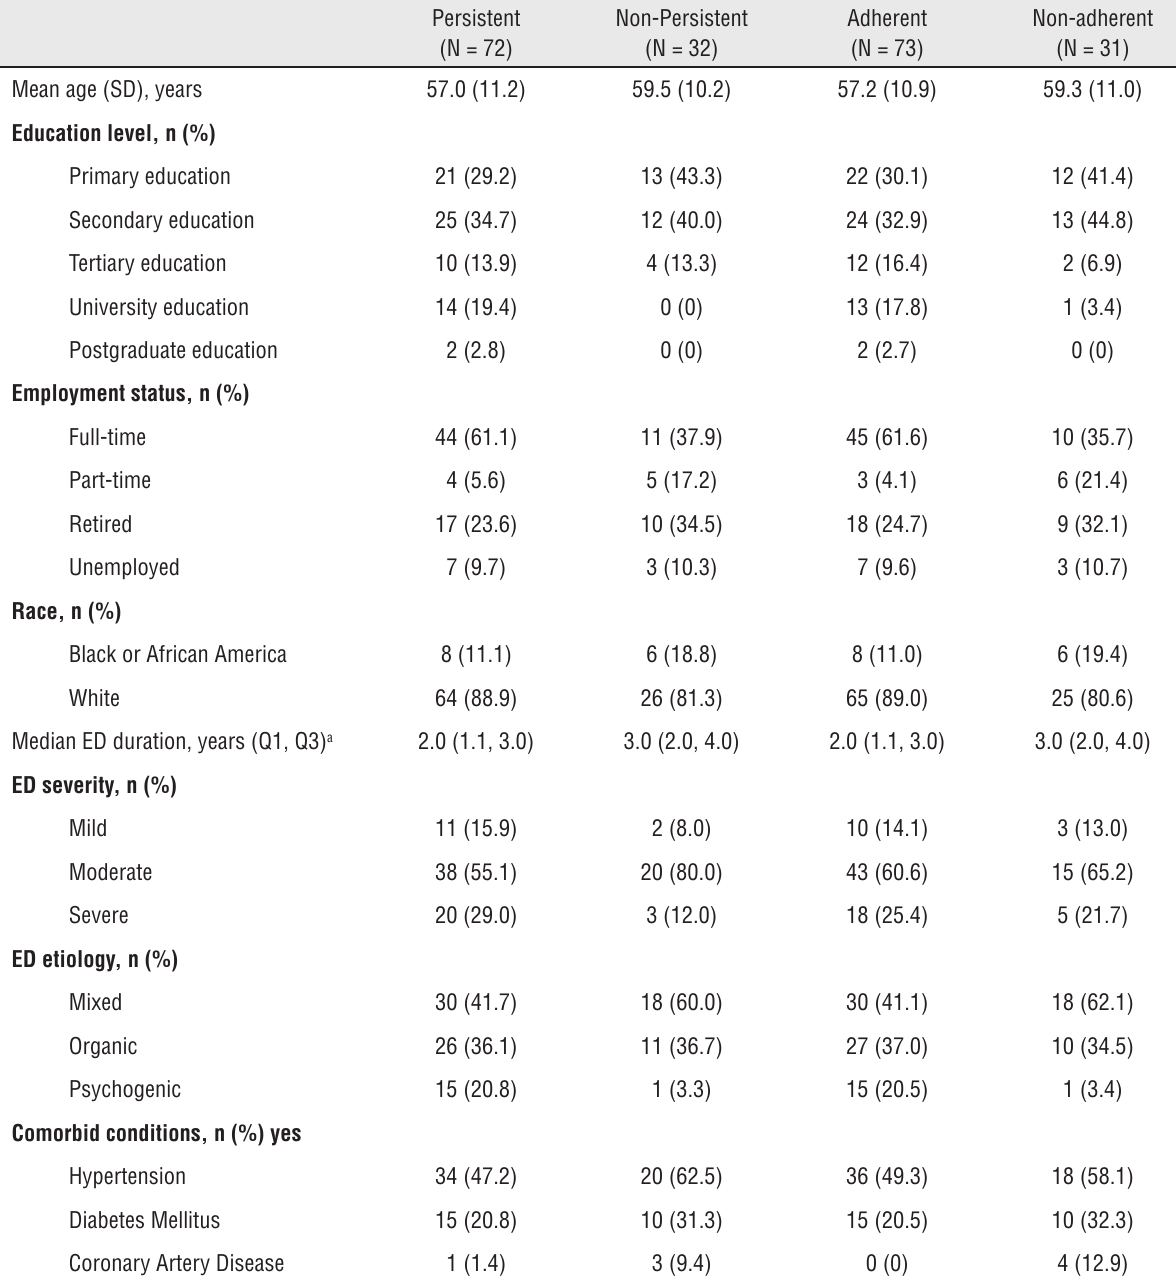
Table 3 - Baseline Characteristics by 6-month Treatment Persistence and